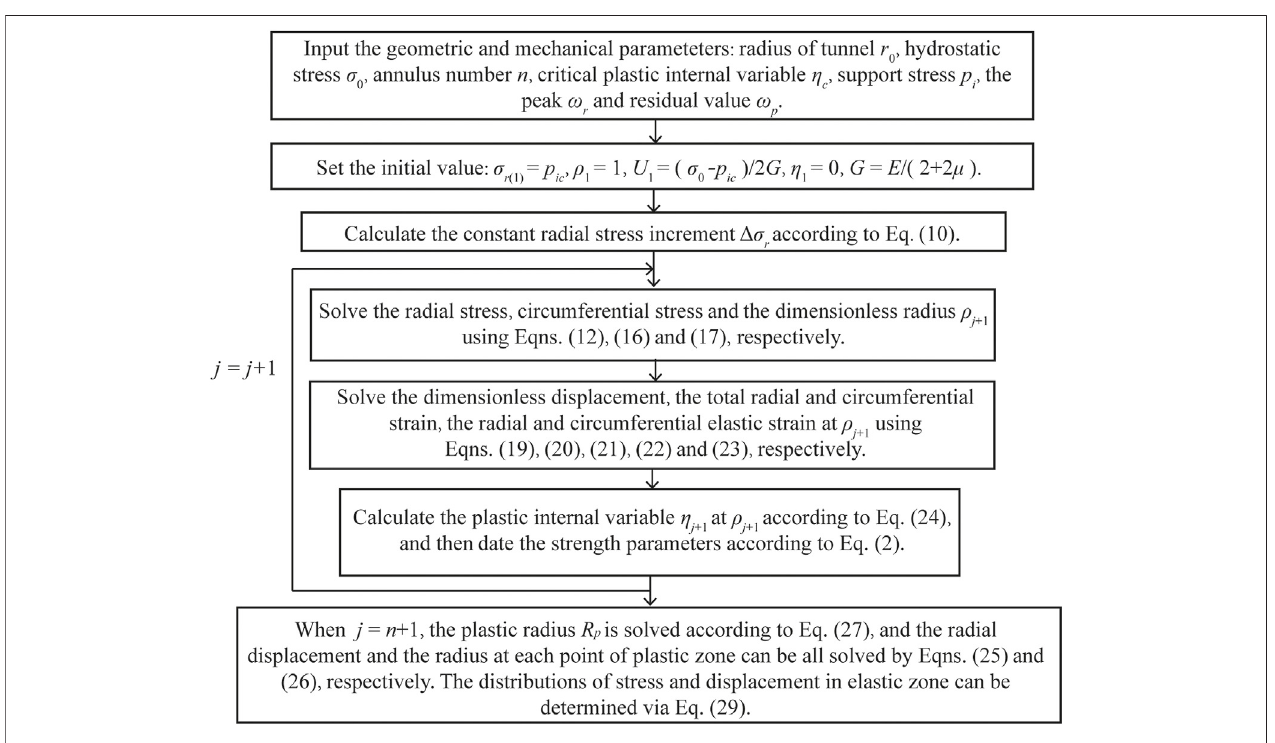
FIGURE 3 | Flow chart of the calculations.